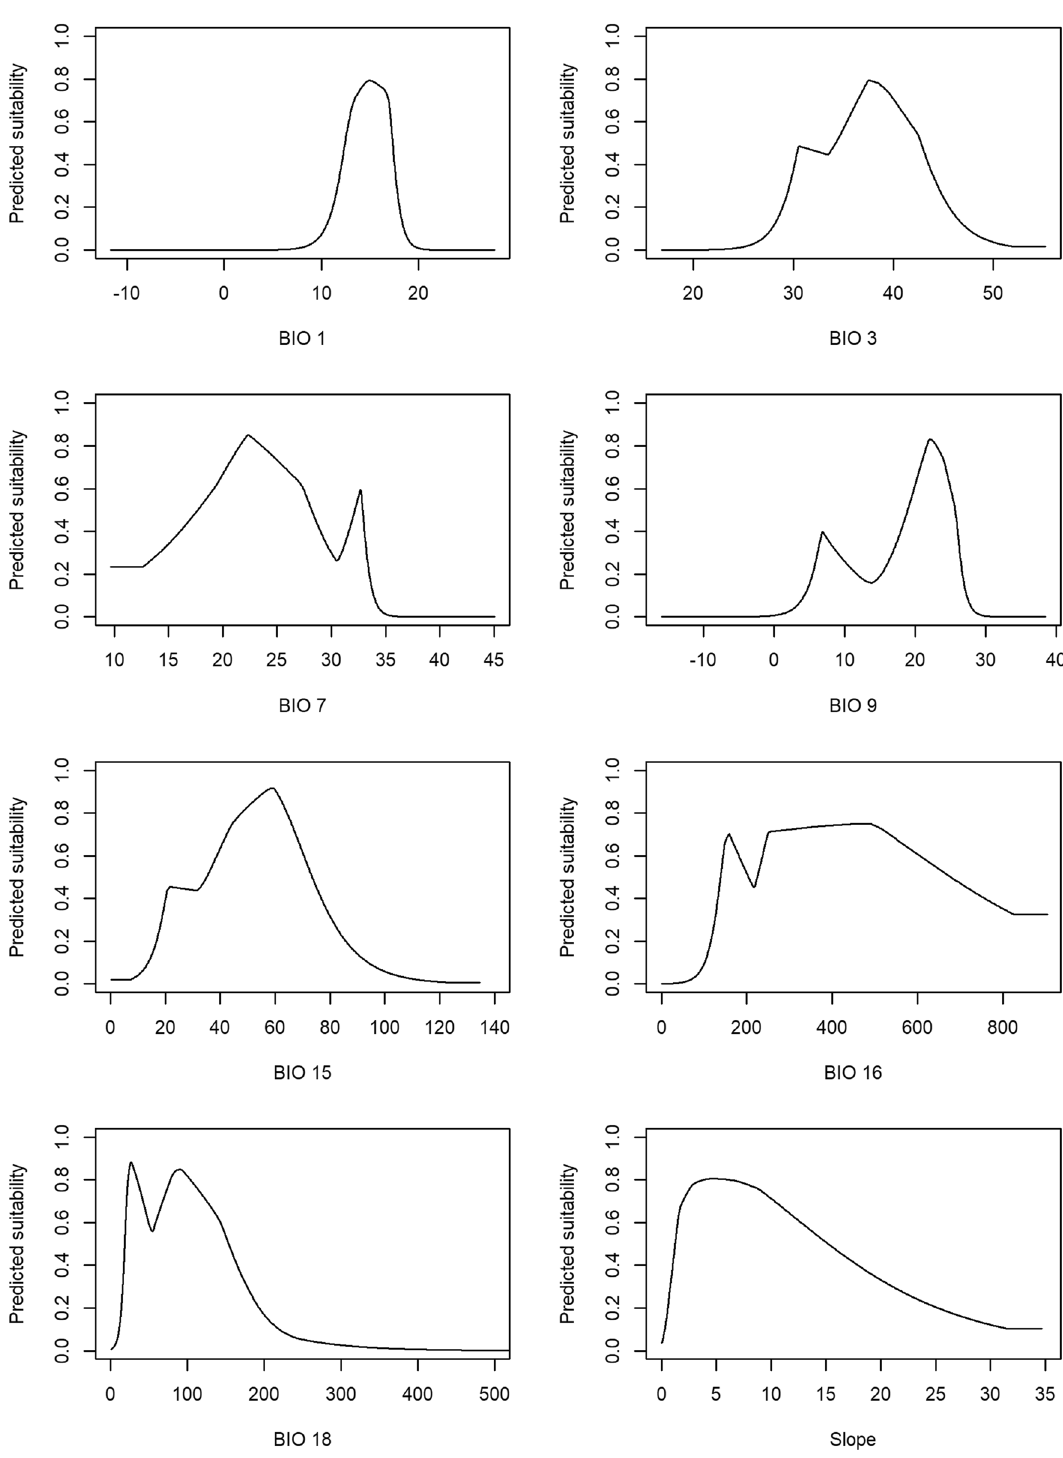
Figure 1. The response curves of predicted suitability values for the selected environmental variables. BIO1 (annual mean temperature, ºC), BIO3 (isothermality, %), BIO7 (temperature annual range, ºC), BIO9 (mean temperature of driest quarter, ºC), BIO15 (precipitation seasonality, %), BIO16 (precipitation of wettest quarter, mm), BIO18 (precipitation of warmest quarter, mm) and Slope